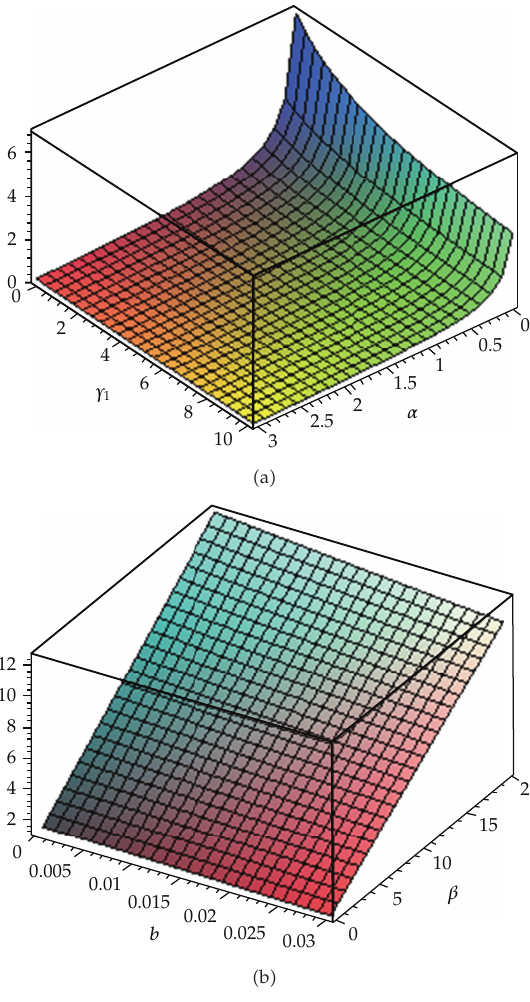
Figure 4: The graphs of the basic reproduction number R 0 in terms of some parameters: (cid:2) a (cid:3) R 0 in terms of α and γ 1 , for the remaining parameter values are the same as Figure 3; the remaining parameter values are the same as Figure